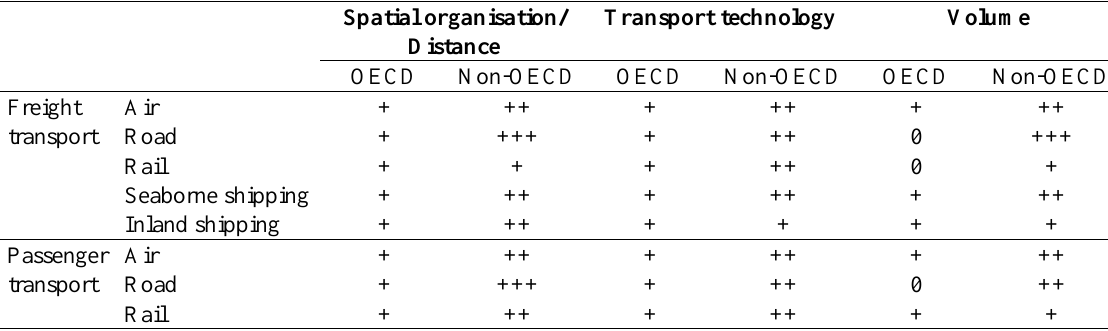
Table 3. Scenario 3: Peripheral